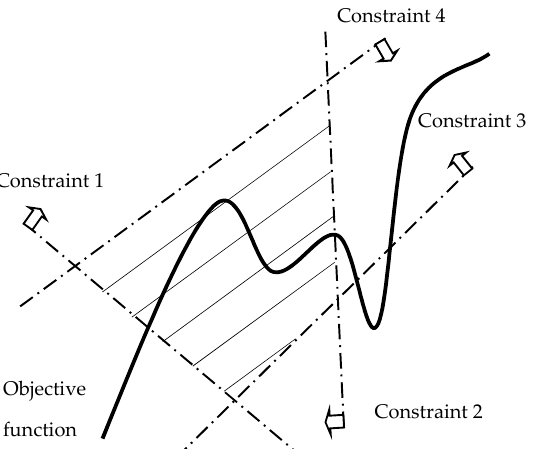
Figure 3. Graphical representation of the process of obtaining the optimal values for the objective function of a domain limited by the constraints.